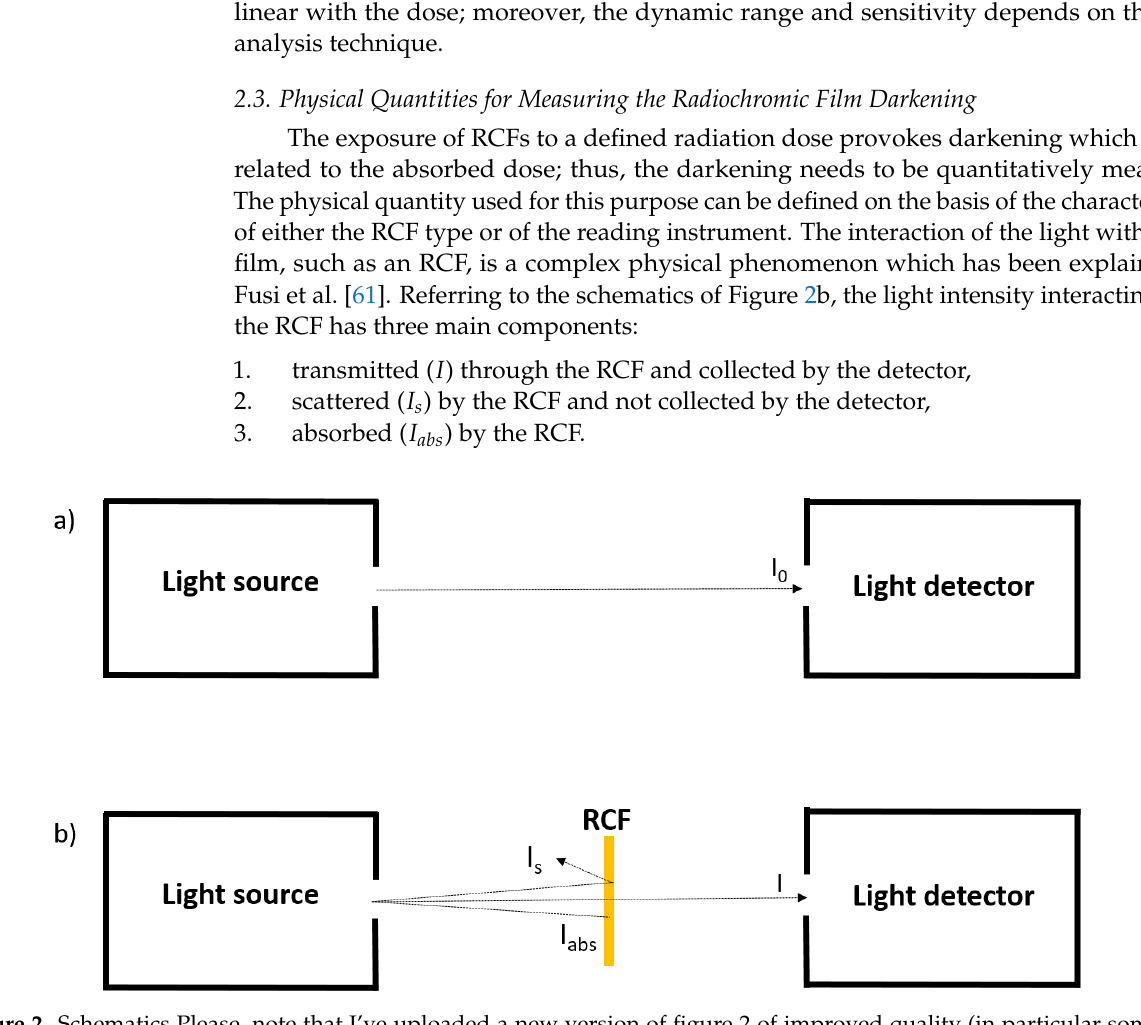
Figure 2. Schematics Please, note that I’ve uploaded a new version of figure 2 of improved quality (in particular some unwanted lines have been removed). showing the principle of measurement of the RCF darkening. I 0 denotes the light intensity detected without RCF ( a ); I s , I abs and I denote the components of light scattered, absorbed and transmitted respectively, by the RCF ( b